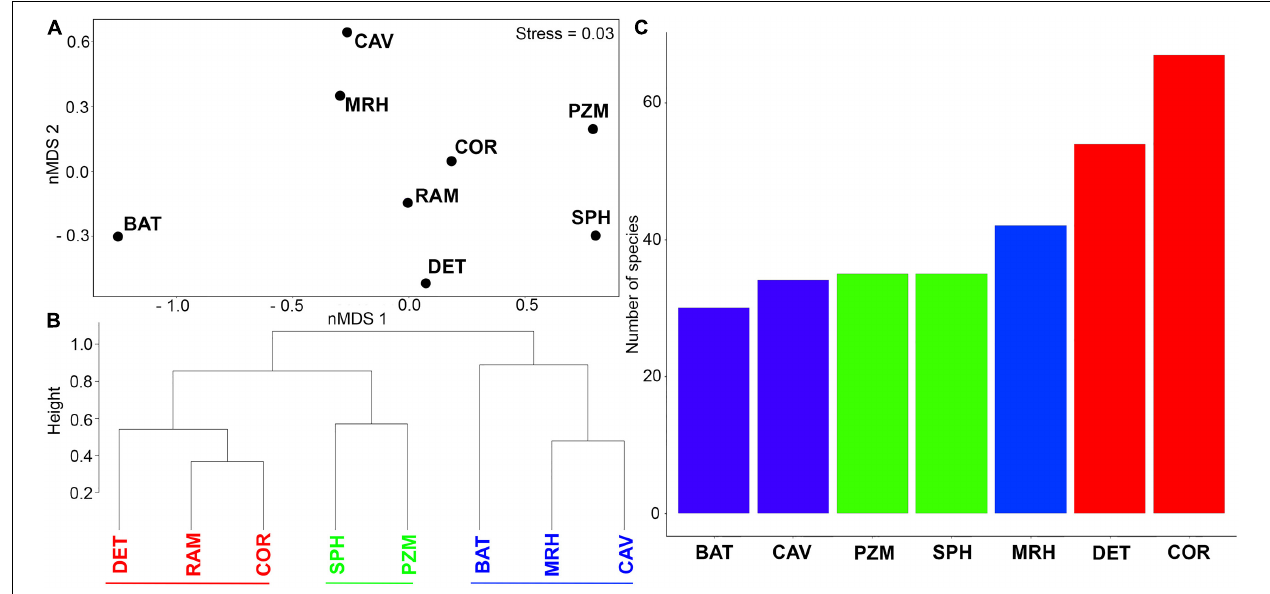
FIGURE 4 | (A) nMDS ordination plot based on presence/absence species data in relation to species habitat affinities. (B) Cluster analysis highlighting the identification of three different groups. (C) Number of species found on the ram assemblage with different ecological affinities. Colors have been used to distinguish among groups (Red: group1; Green: group2; Blue: group3). Abbreviations are defined as follows: BAT, bathyal habitats; CAV, caves; COR, coralligenous reefs; DET, detritic bottoms; MRH, mesophotic reef habitats; PZM, Posidonia and Zosteracea meadows; RAM, ram 13; SPH, shallow shelf photophilic